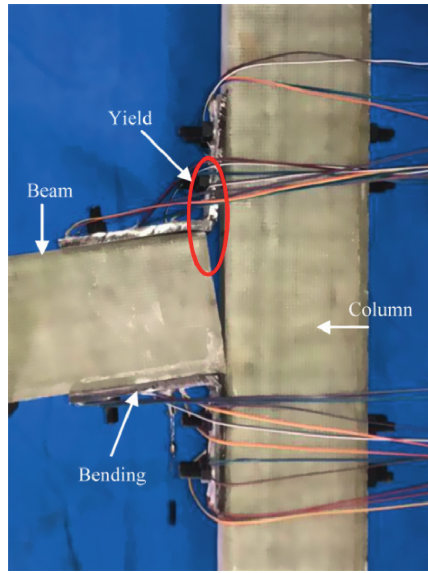
Figure 7: Yield at the corner of the top angle steel (TJ-110).